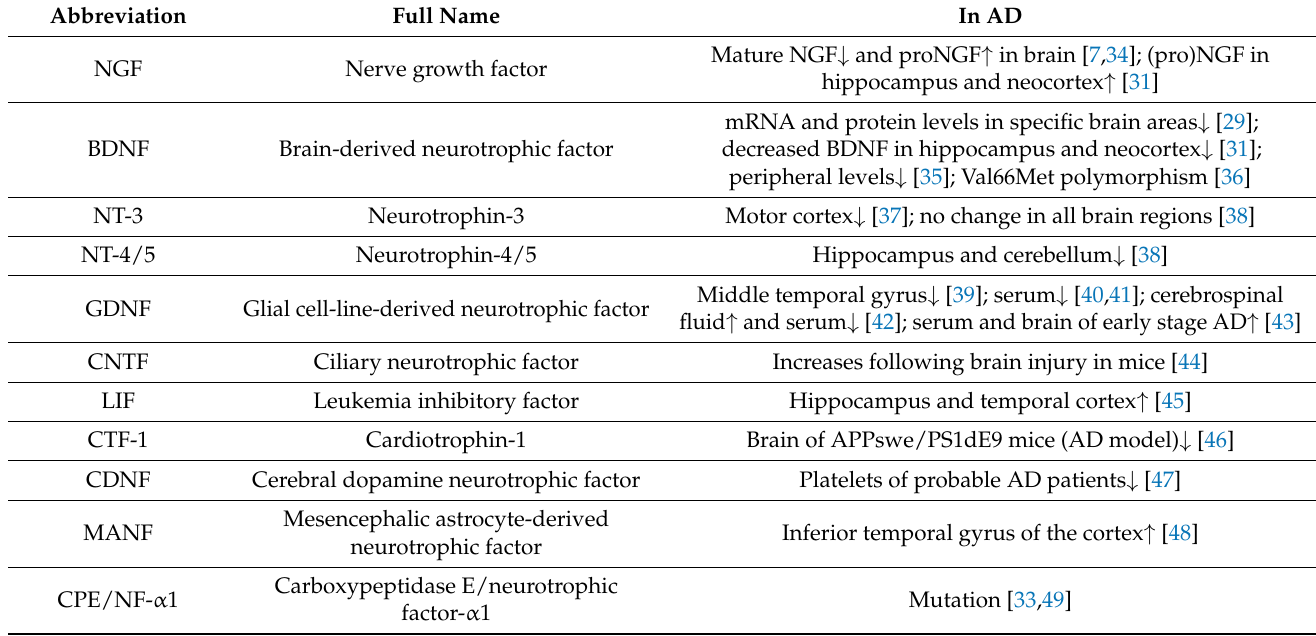
Table 1. Neurotrophic factors and growth factors altered in